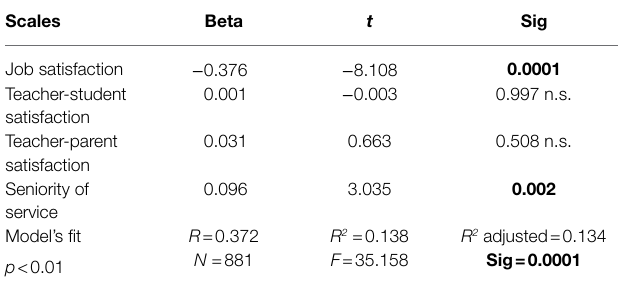
TABLE 2 | Regression